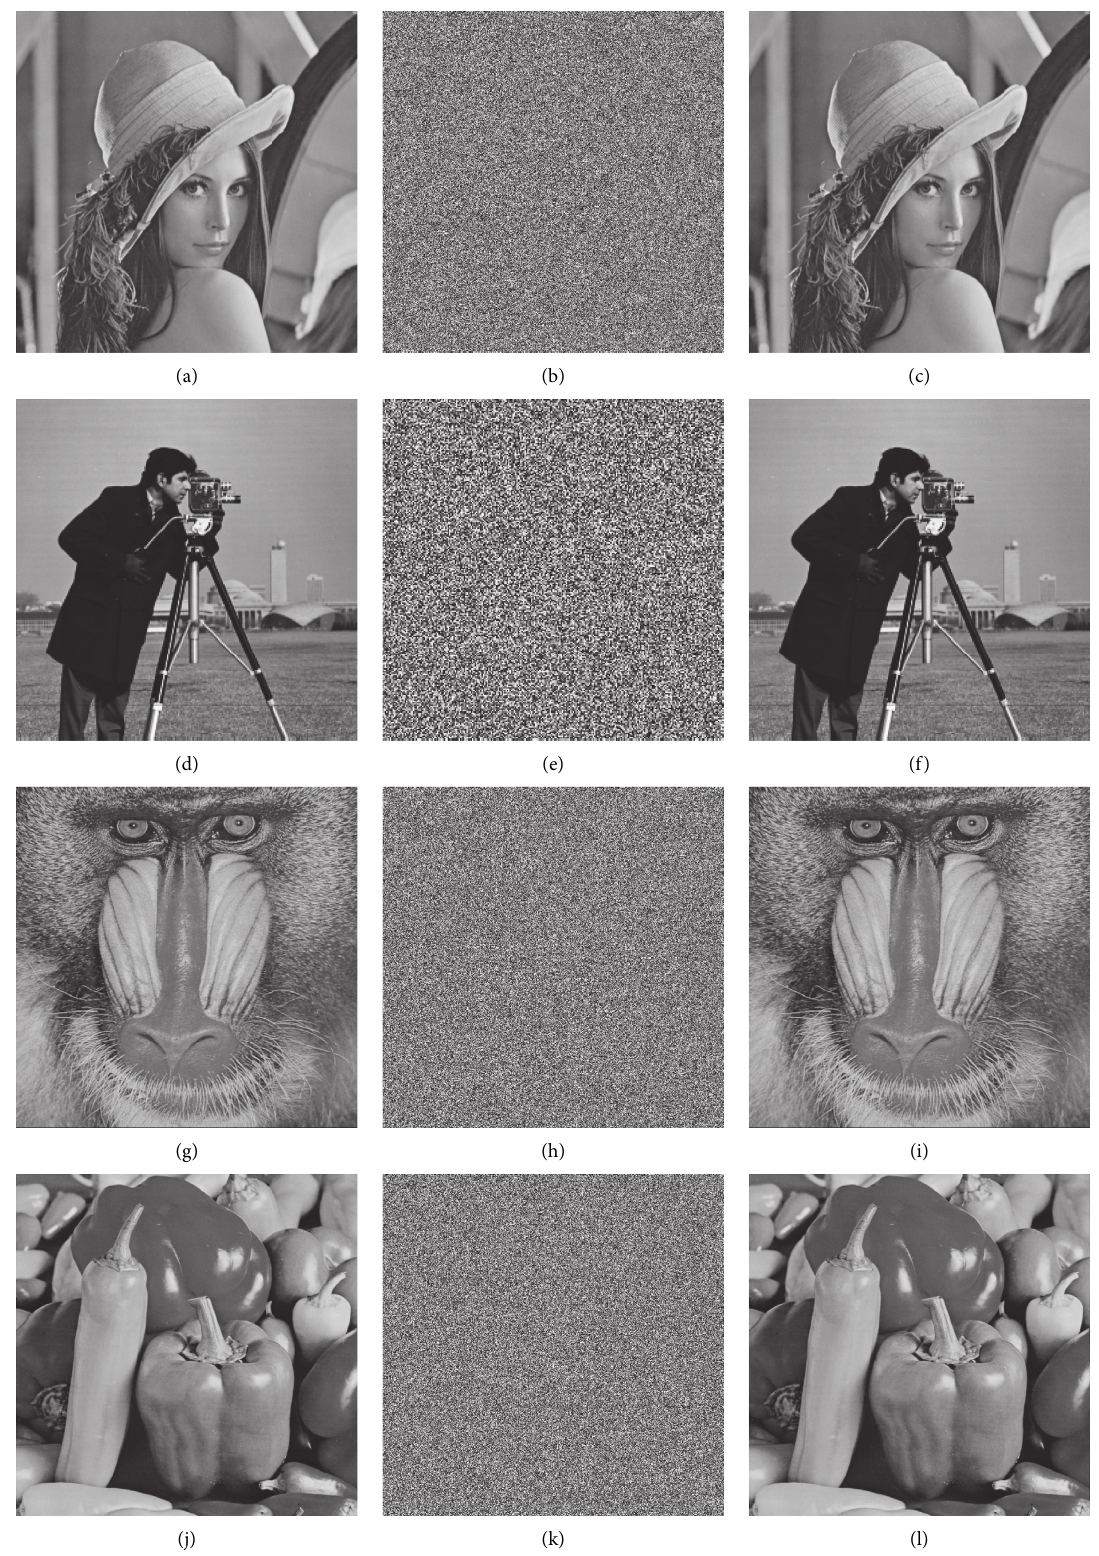
Figure 13: Encryption and decoding results: (a) Lena plain image; (b) Lena scrambled picture; (c) Lena decrypted image with right keys; (d) Cameraman plain image; (e) Cameraman encrypted image; (f) Cameraman decrypted image with right keys; (g) Baboon plain image; (h) Baboon encrypted image; (i) Baboon decrypted image with right keys; (k) Peppers plain image; (l) Peppers scrambled image; and (m) Peppers decrypted image with right